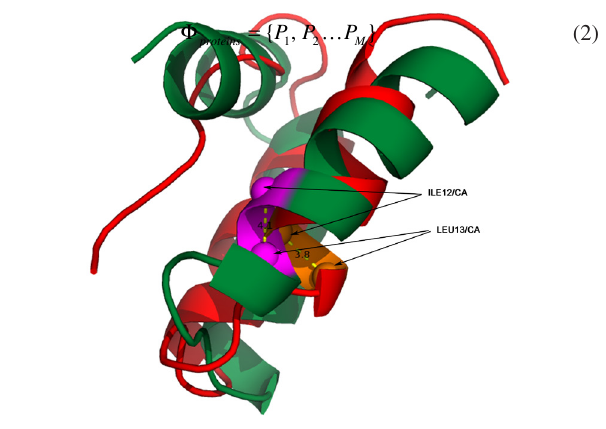
Figure 3. Superimposition of the native structure and a decoy structure (AXPROA00-MIN) for a protein (PDBid:1FC2) taken from the fisa decoy set. The native structure is in red, and the decoy structure is in green. The structures are superimposed using MUSTANG 58 . The distance between Ile12/C a and Leu13/C a atoms is 3.8 Å and 4.1 Å in the native and the decoy structures,